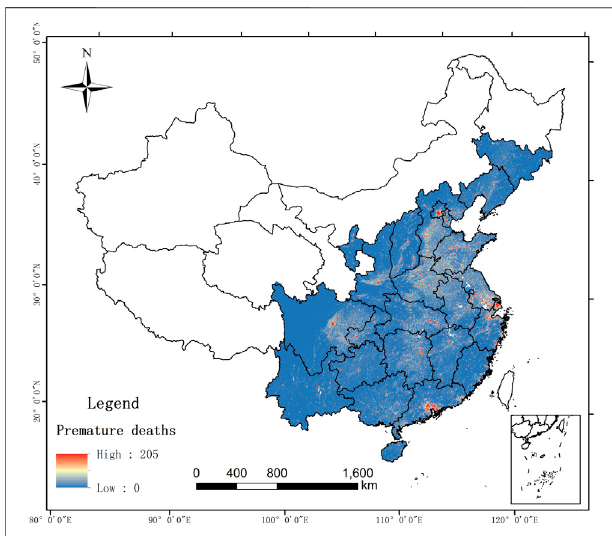
FIGURE 11 | Spatial distribution of premature deaths assessed by the preferred combination project of PM 2.5 dataset.